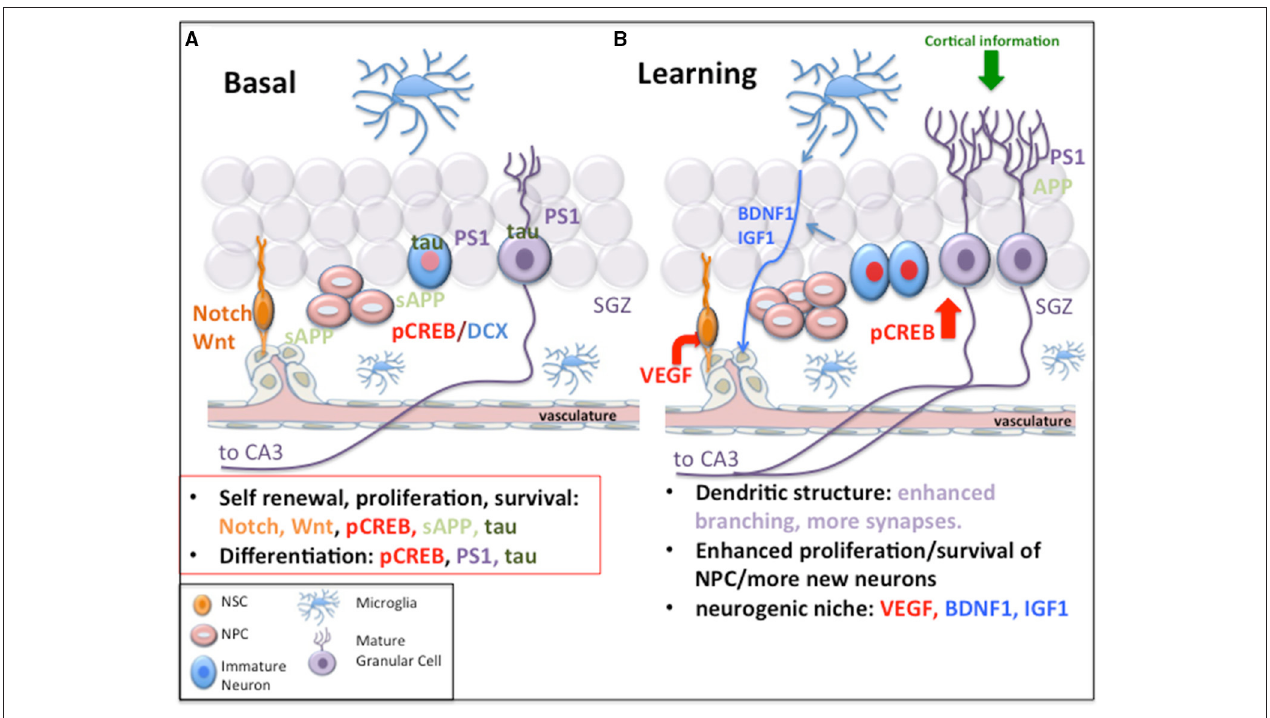
FIGURE 1 | Common mechanisms of neurogenesis and Alzheimer’s disease and the implications for learning. (A) Signals that play a role in neurogenesis, such as Notch-1, Wnt/ β -catenin, CREB, sAPP, tau, and presenilin-1 are implicated in Alzheimer’s disease. (B) Following learning, changes in the neurogenic niche include alterations in Notch and sAPP, increased expression of neurotrophins such as VEGF, BDNF, and IGF which enhance angiogenesis and provide support for the neurogenic niche and lead to increased neurogenesis. Upregulation of CREB signaling by neural progenitor cells and neurons may promote survival and maturation of NPCs. Increased dendritic branching of mature neurons and synaptic plasticity may be mediated by presenilin-1 and APP. The factors mediating these processes are dysfunctional or compromised in Alzheimer’s disease, suggesting that defective neurogenesis may affect hippocampal function in Alzheimer’s